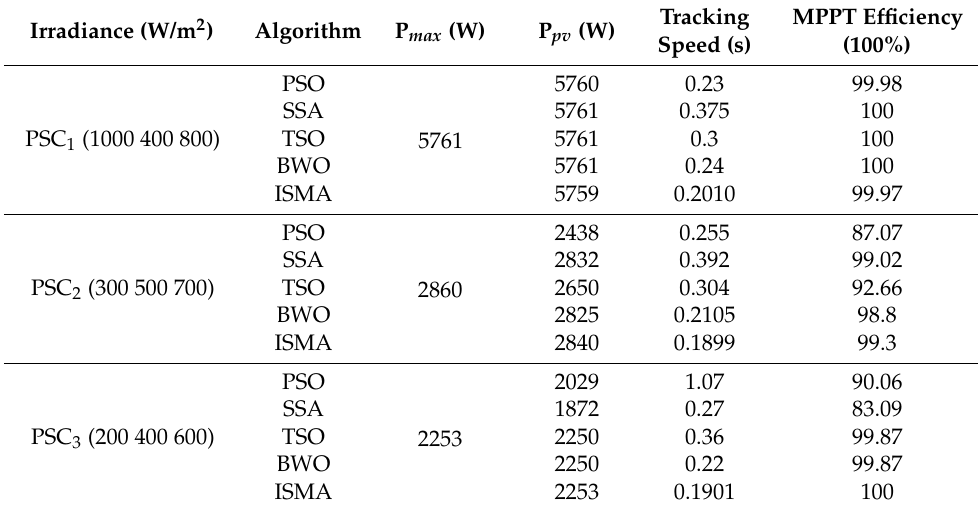
Table 3. Comparison of performance parameters of different control algorithms. Irradiance (W/m 2